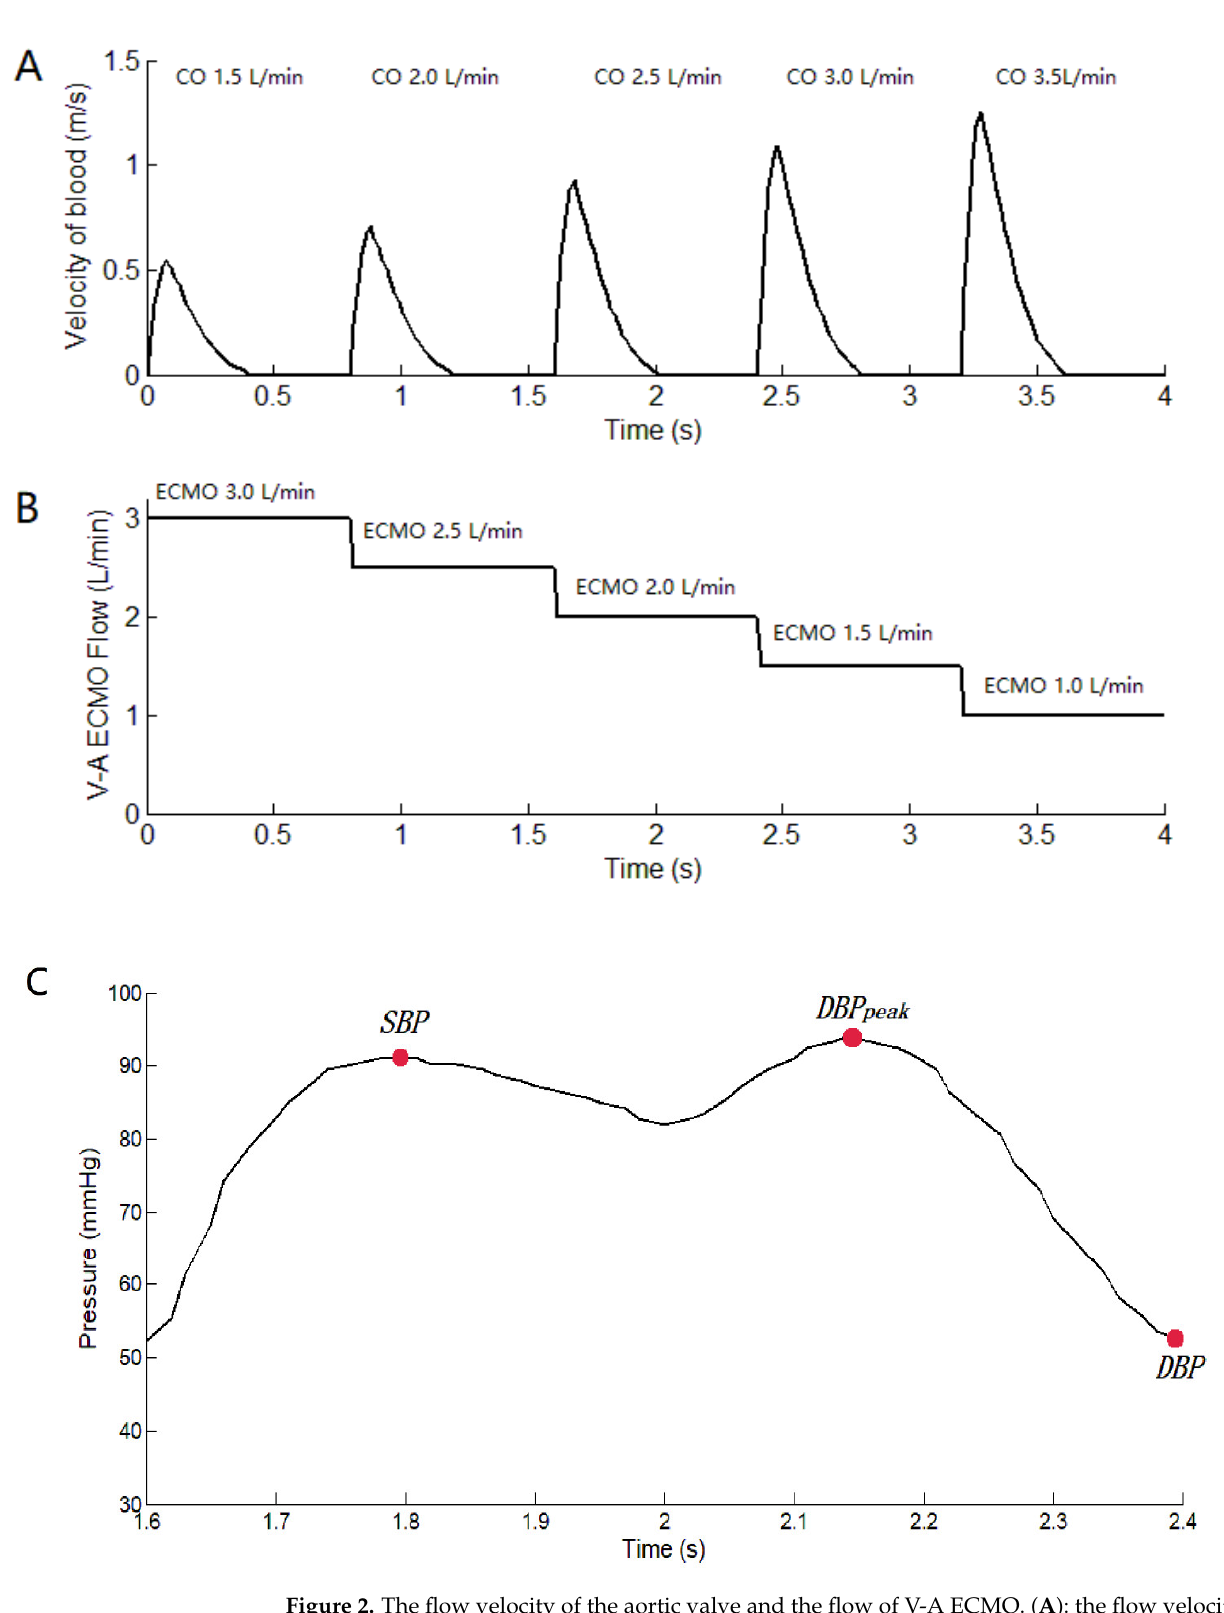
(cid:82) Vdt A HR   Vdt ∗ A av ∗ HR av